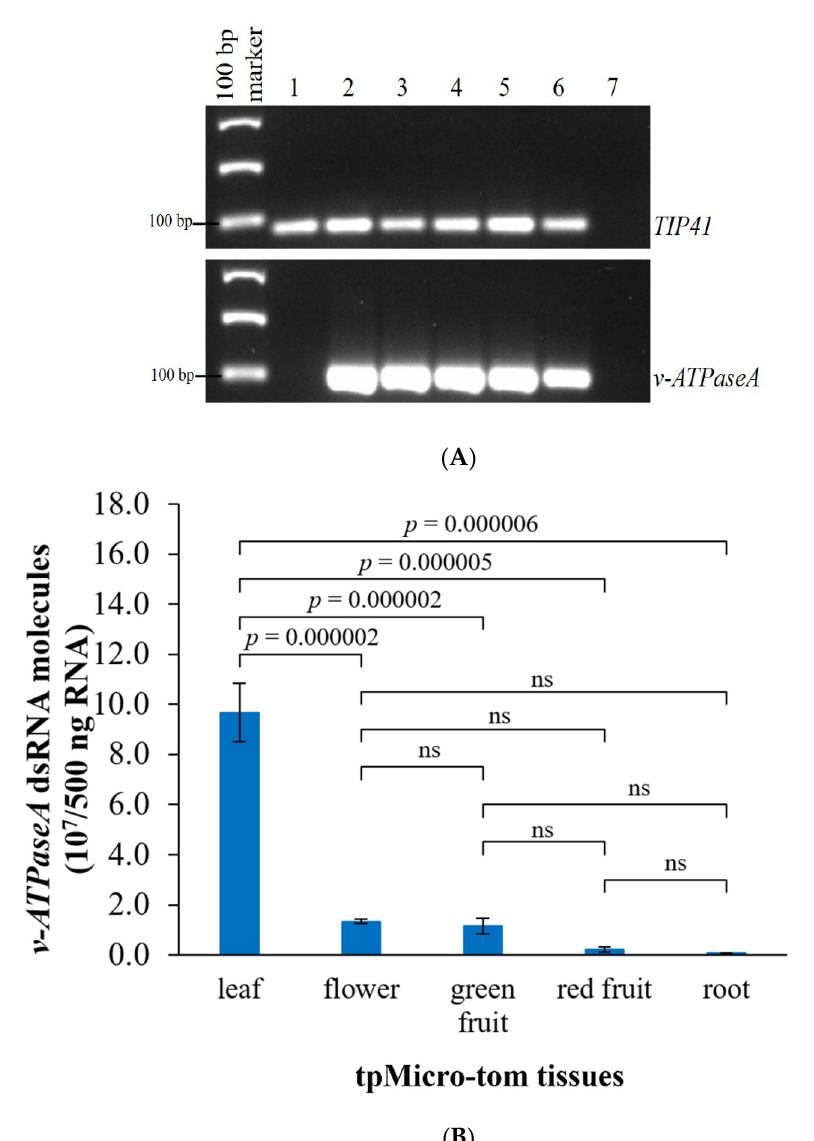
Figure 3. dsRNA production in different tpMicro-tom tissues. ( A ) Qualitative assessment of dsRNA production using end-point PCR and agarose gel that show dsRNA presence in various tpMicro-tom tissues; Lane 1 = WT leaf; Lane 2 = transplastomic (tp) leaf; Lane 3 = tp flower; Lane 4 = tp green fruit; Lane 5 = tp red fruit; Lane 6 = tp root; and Lane 7 = no template control. ( B ) Absolute quantification of v-ATPaseA dsRNA molecules in 500 ng tpMicro-tom total RNA using ddPCR. Data are expressed as mean quantity ± SEM, n = 3. P -values were calculated using Tukey’s HSD (one-way ANOVA) for each comparison and are indicated on the graph. “ns” = not significant ( p > 0.05) according to the Tukey’s HSD test.